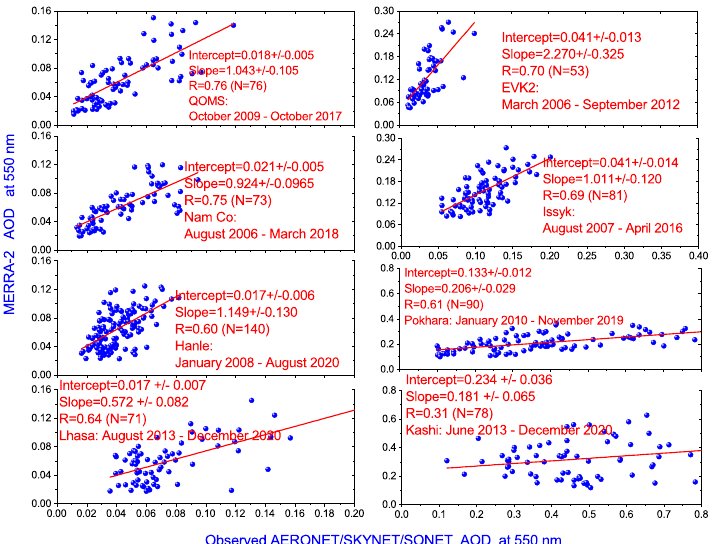
Figure 1. Scatter plot of AOD at 550 nm from MERRA2 and observation taken from AERONET, SKYNET and SONET at various sites in the HKH region. Table 2. Yearly AOD (550 nm) trend (AOD year − 1 ) at different sub-regions in the Hindu Kush Himalayan region in 1980–2020 using MERRA-2 reanalysis data. The results also show a Pearson correlation coefficient (R) and confidence level